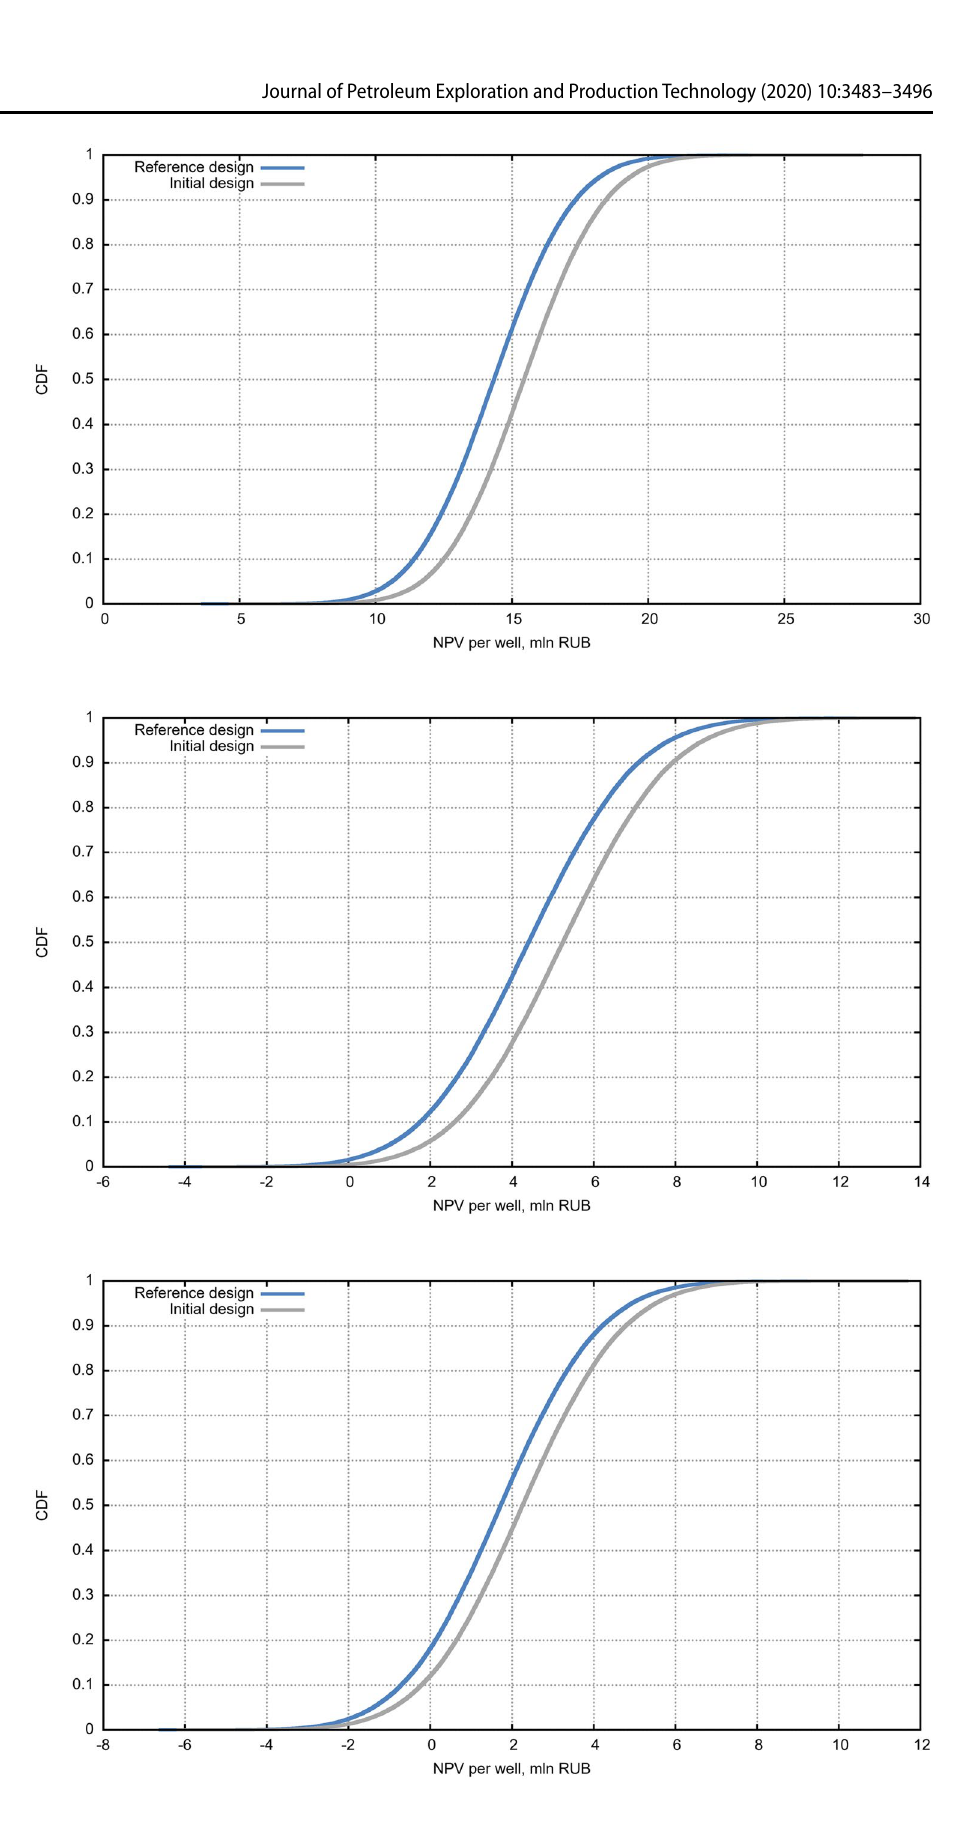
Fig. 16 Cumulative distribution functions (CDF) for the NPV of the drilling projects according to scenario S1